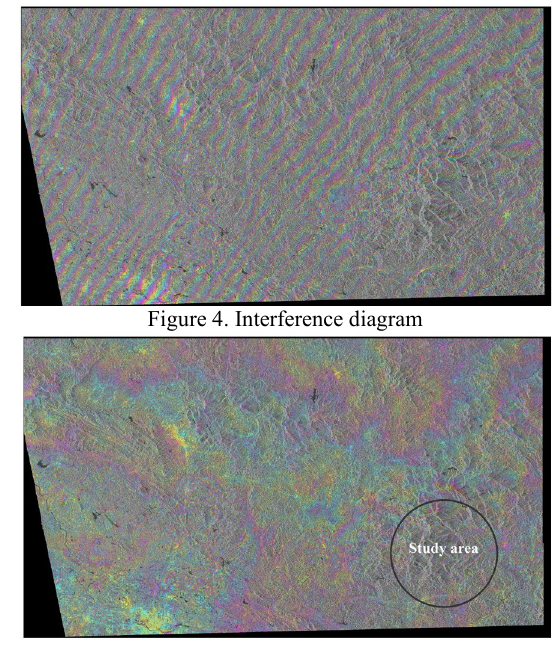
Figure 3 Flow chart of two-pass method